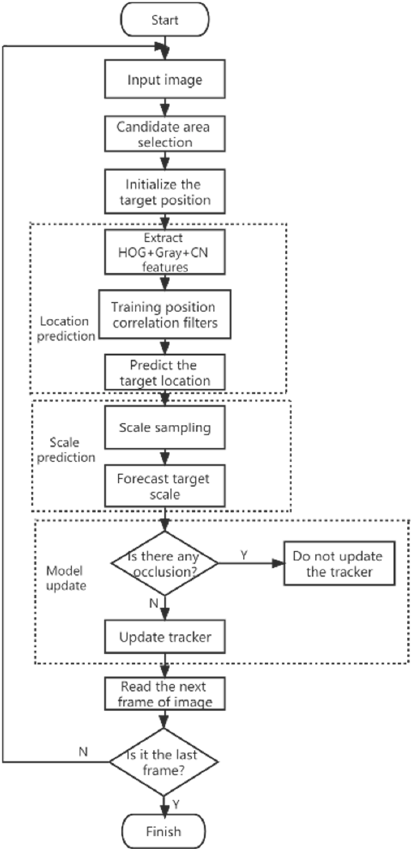
Figure 1. The flow chart of the proposed algorithm.